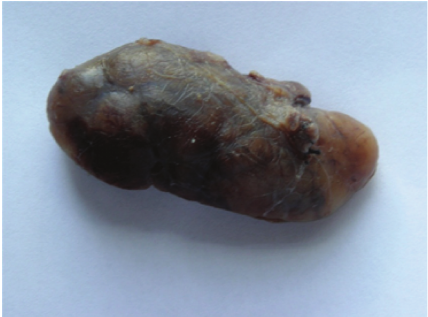
Figure 2: AP X-ray of the right clavicle showing osteitis fibrosa cystica lesion with a pathologic fracture (on admission).